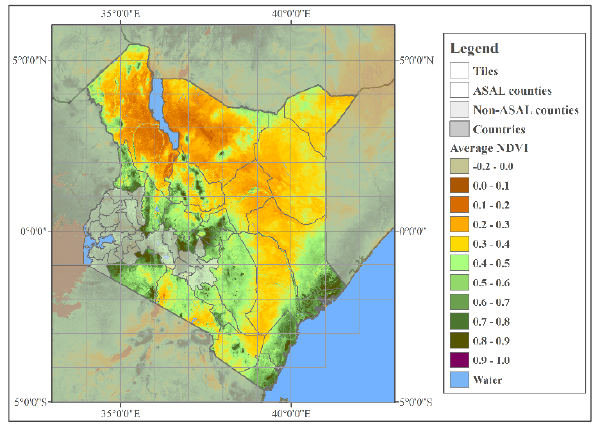
Figure 1: Average annual NDVI for ASAL counties of Kenya. Non-ASAL counties are shown in grey. The map also shows the 1° x 1° tiling system in which MODIS data is processed 3.1.1 MODIS Data: The NDMA drought indicators are derived from MOD13Q1 and MYD13Q1 NDVI collection 5 products of the MODIS Terra and Aqua satellites from LP DAAC (from 2000 onwards). These products are gridded level-3 data in approximately 250m spatial resolution in Sinusoidal projection with a (combined) temporal resolution of 8 days. The level-3 data are calculated from the level-2G daily surface reflectance gridded data (MOD09 and MYD09 series) using the constrained view angle – maximum value composite (CV-MVC) compositing method (Solano et al., 2010).